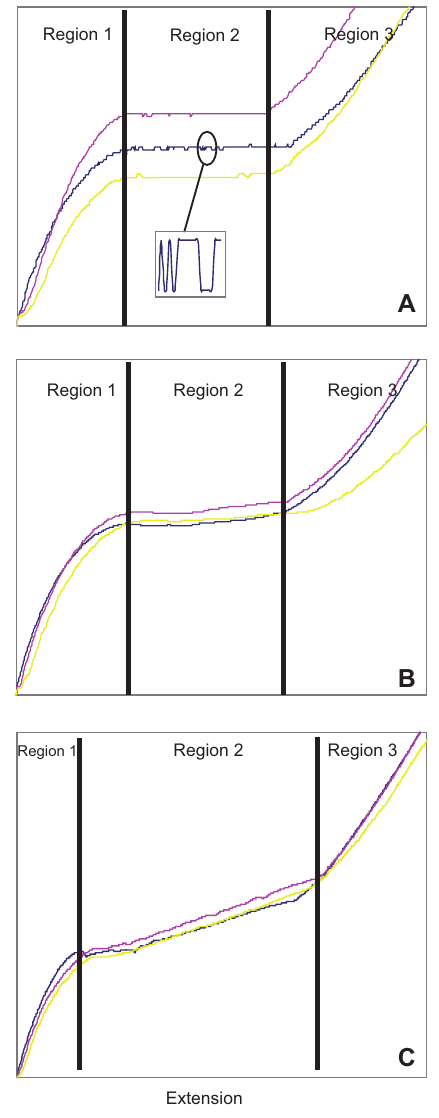
Figure 1 Load-extension behavior for NiTi Shape memory alloy wires of (A) 1 mm, (B) 2 mm and (C) 3 mm diameters at low, interme- diate and high displacement